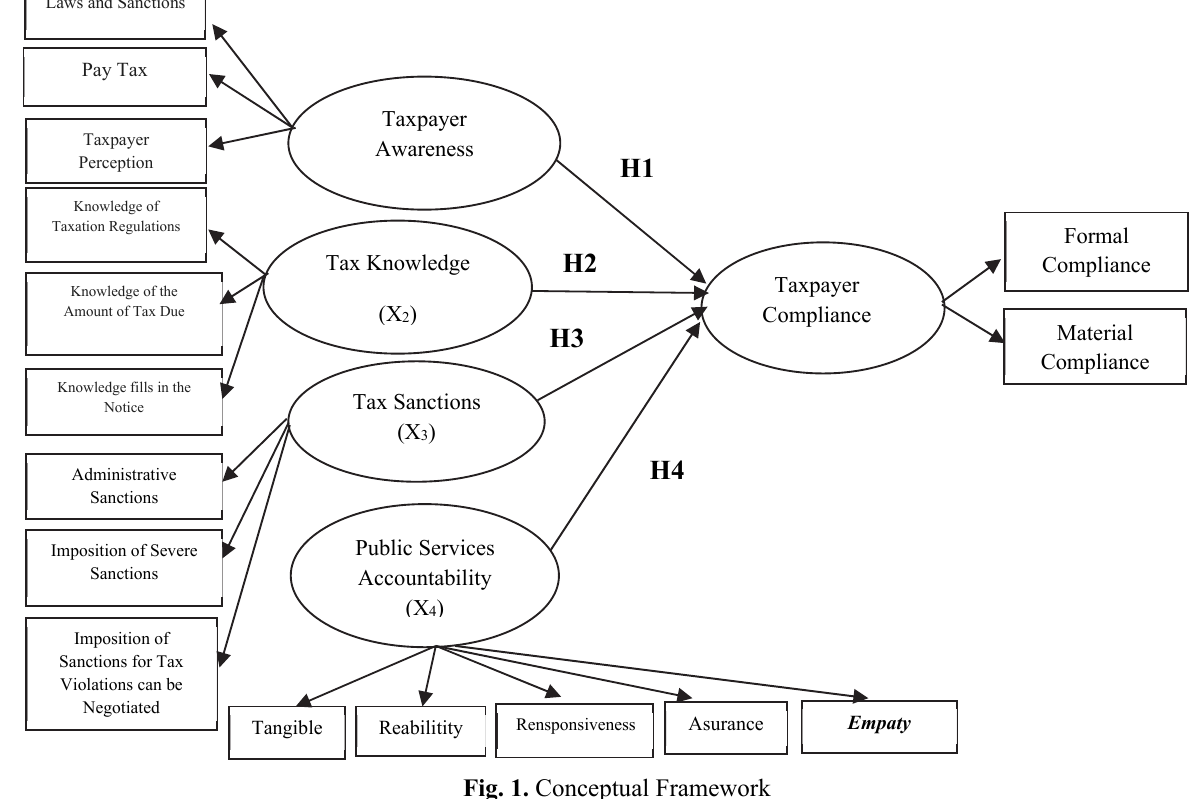
Fig. 1. Conceptual